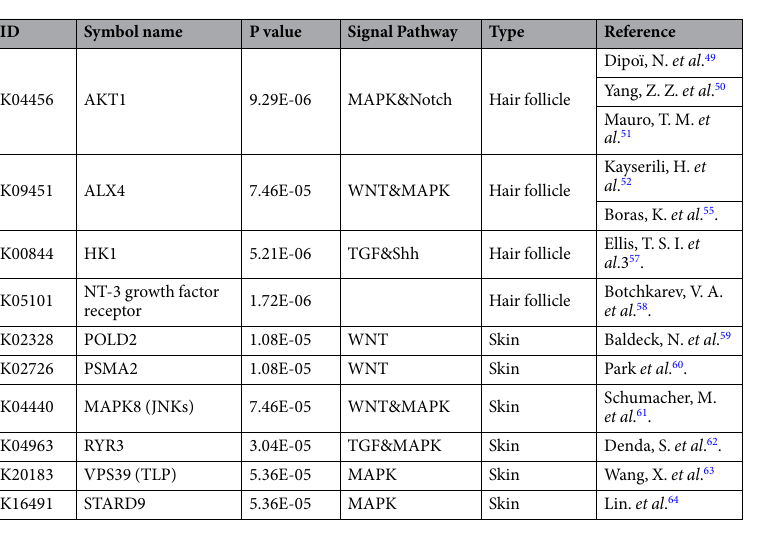
Table 3. Biological inferences analysis of top-hit